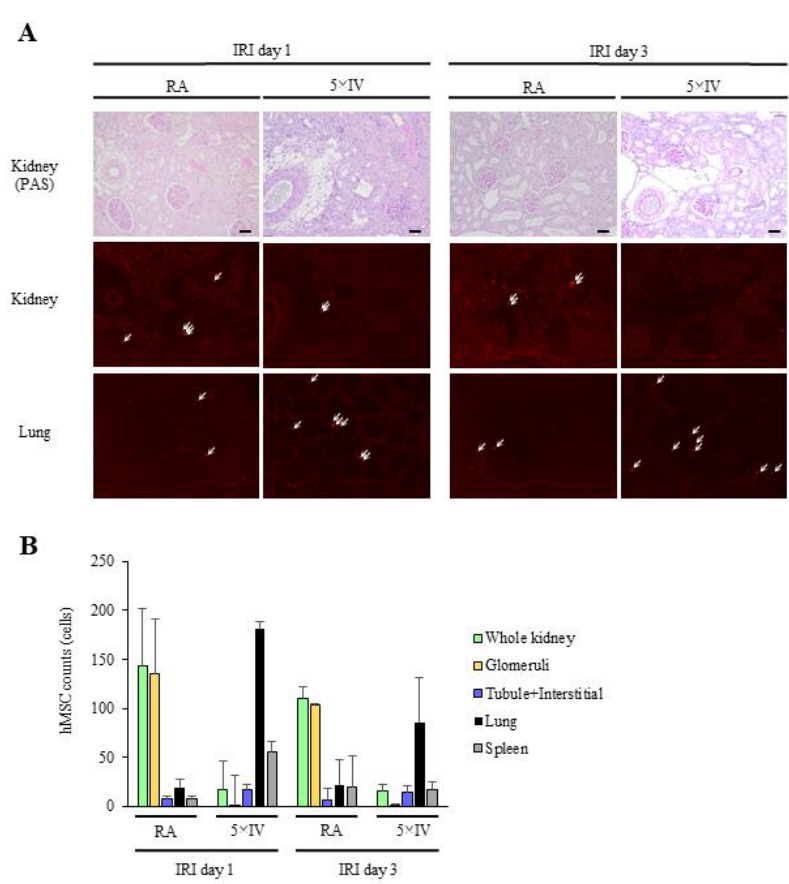
Figure 3. Examination of post-IRI kidney sections comparing the different routes of administration of hMSCs. ( A ) Representative distribution of arterially delivered CM-DiI-stained hMSCs (RA group, 5 × 10 5 hMSCs/rat, red-labeled cells; arrows) to the IRI kidney shows that significantly more implanted hMSCs were retained compared with the intravenously injected group (5 × IV group, 2.5 × 10 6 hMSCs/rat, red-labeled cells; arrows). The photos of PAS staining above show the same kidney sections, × 100. (scale bar = 50 µ m) ( B ) Difference between the number of CM-DiI-stained hMSCs delivered intra-arterially and intravenously in 10 random fields ( × 100) in kidney, lung, and spleen at days 1 and 3 post-IRI. In the intravenously injected group, grafted hMSCs accumulated primarily in the lung. Abbreviations: hMSCs, human mesenchymal stem cells; IRI, ischemia-reperfusion injury; RA, renal artery injection; IV, intravenous injection; PAS, periodic acid-Schiff.